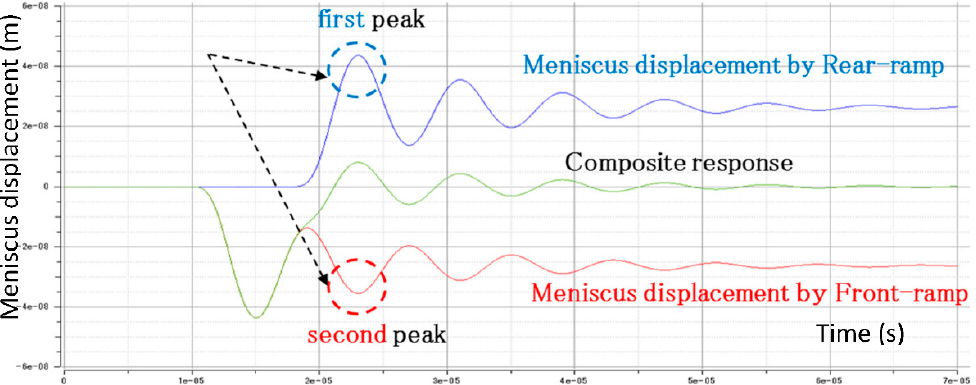
Figure 6. Front ramp and rear ramp in W waveform.